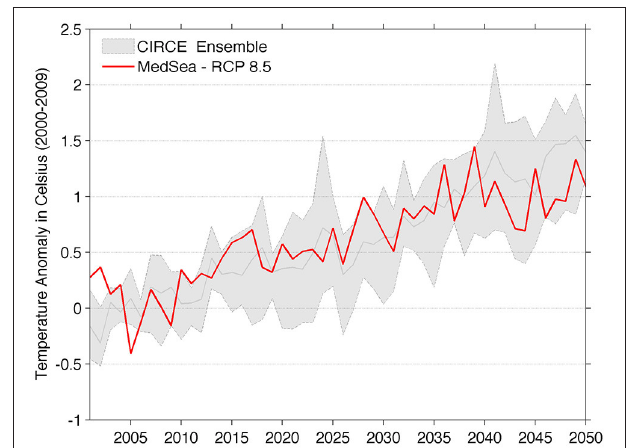
FIGURE 1 | Comparison between the Mediterranean Sea surface annual mean temperature anomaly of MedSea dataset (red line) and the ensemble mean anomaly for the five models of CIRCE project (gray solid line). The shaded area represents the min-max spread of the multi-model ensemble. Sea surface temperature anomalies were computed with respect to the 2000–2009 mean